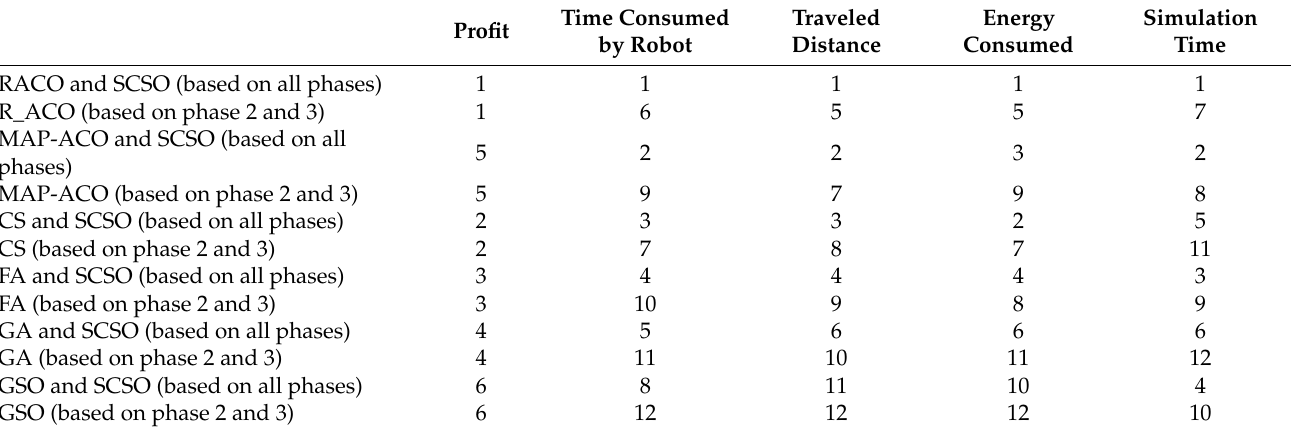
Table 7. Ranking of each method in all evaluation parameters. Time Profit